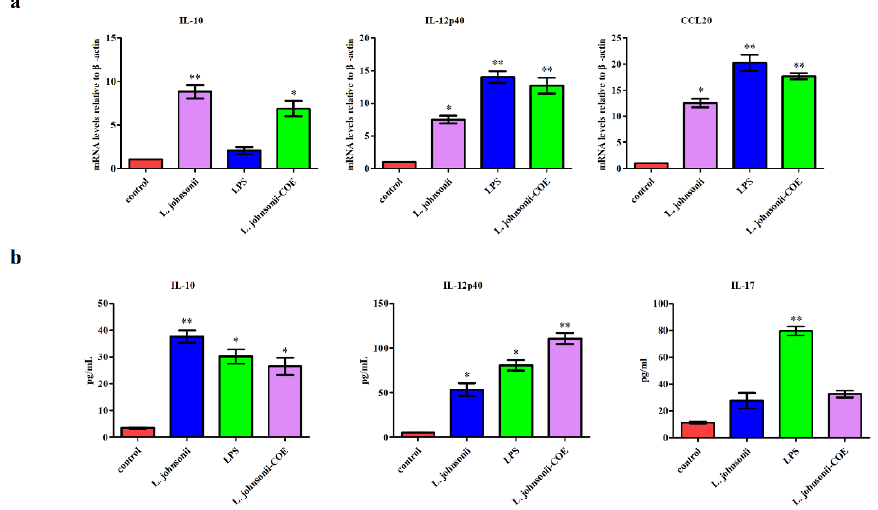
Figure 5. The expression of cytokines in MoDCs primed by L. johnsonii-COE , LPS, and L. johnsonii and analysis of effector T cell differentiation. ( a ) Real-time PCR measured the transcriptional of IL-12p40, IL-10, and CCL20 in MoDCs. ( b ) Different treated MoDCs co-cultivated with allogenic CD4 + T cells for 72 h, medium was collected and ELISA analysis of the cytokines secretion of IL-12p40, IL-10, and IL-17. * ( p < 0.05) and ** ( p < 0.01).